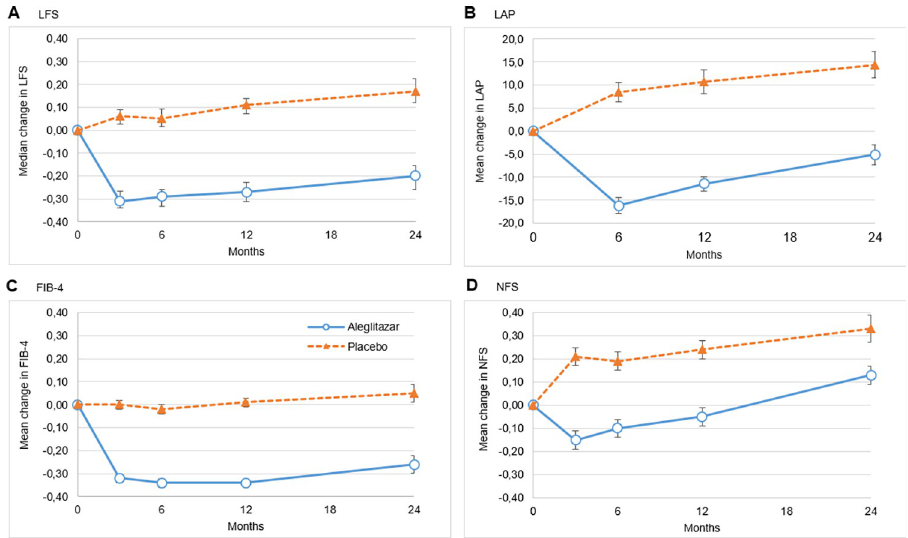
Fig 1. Change in NITs of liver steatosis and fibrosis from baseline. Value at baseline for A: Median LFS of 0.60 for placebo and 0.63 for aleglitazar, B: Mean LAP of 69.5 for placebo and 67.8 for aleglitazar, C: Mean FIB-4 of 1.40 for placebo and 1.44 for aleglitazar, D: Mean NFS of -0.50 for placebo and -0.41 for aleglitazar. Error bars indicate 95% CIs. Change from baseline is significantly different in the aleglitazar and the placebo group at all timepoints � 3 mohs for all proxies (all P <